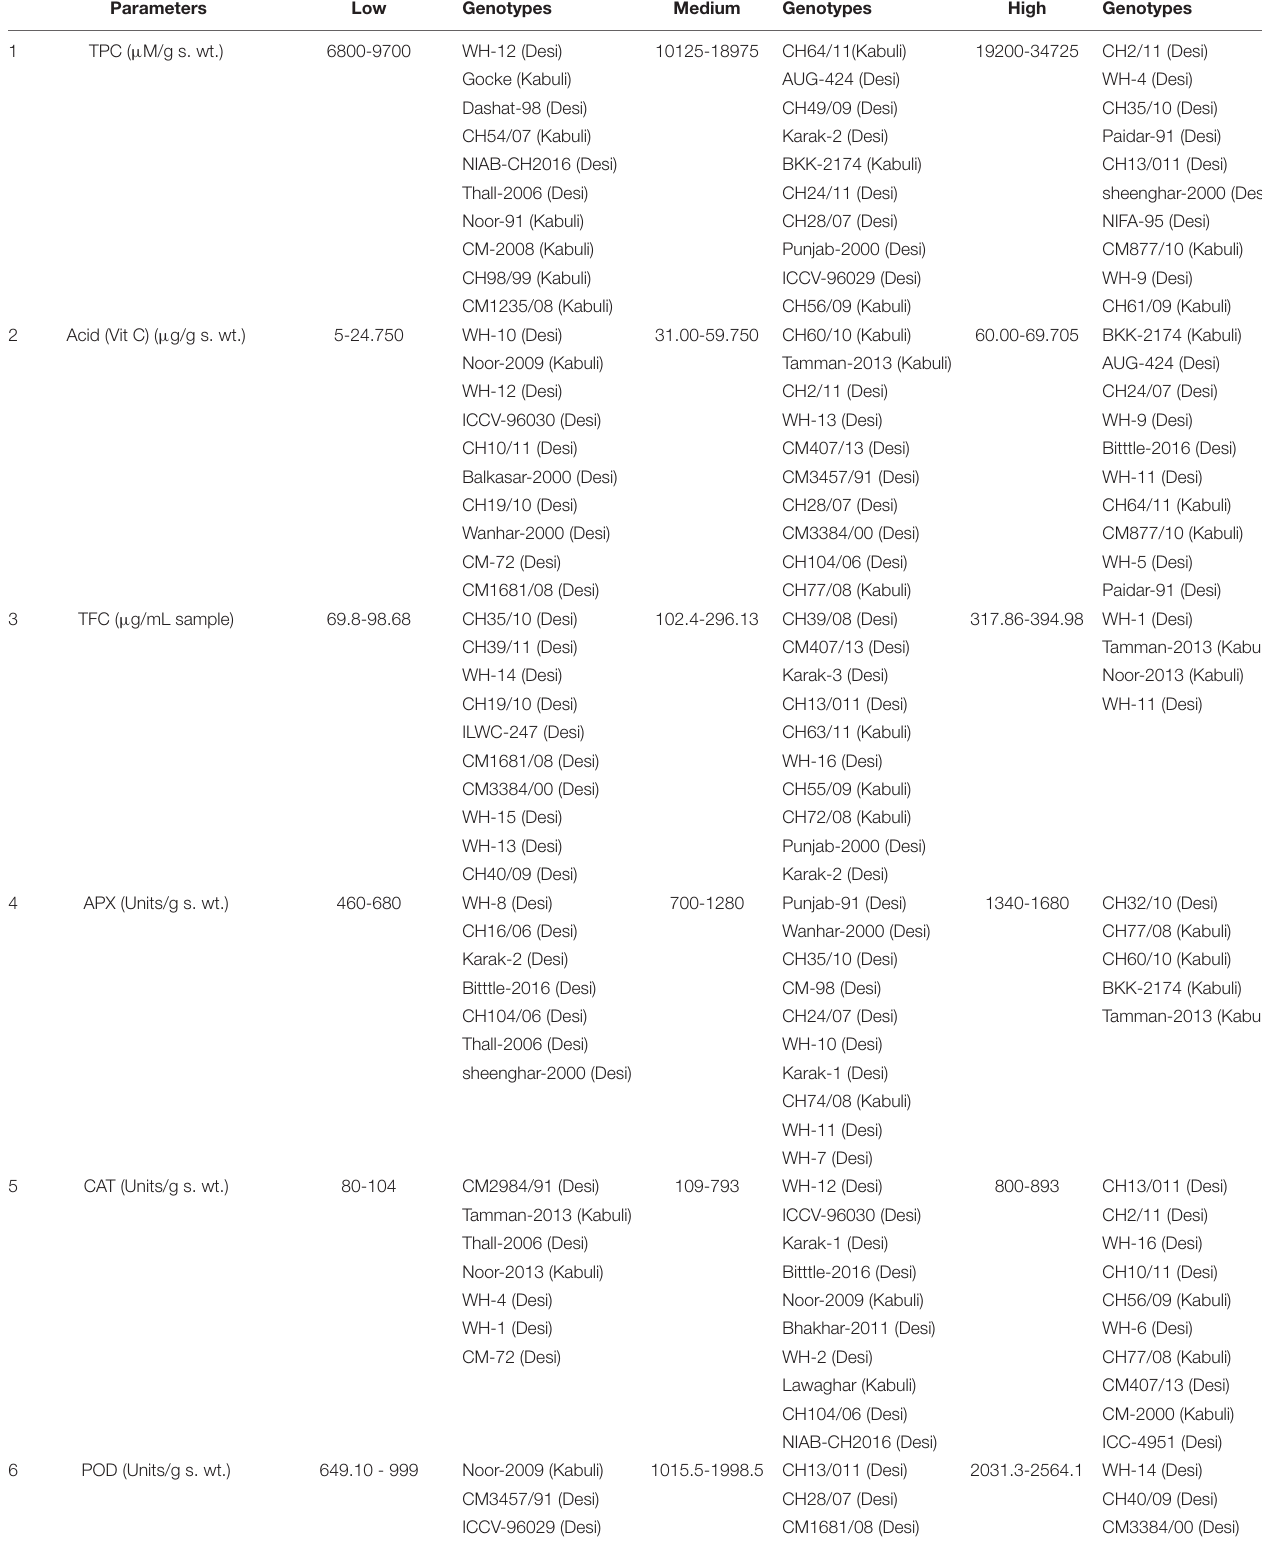
TABLE 2 | Scale for categorization of Chickpea genetic resource in high, medium, and low value for different biochemical parameters. Parameters Low Genotypes Medium Genotypes High